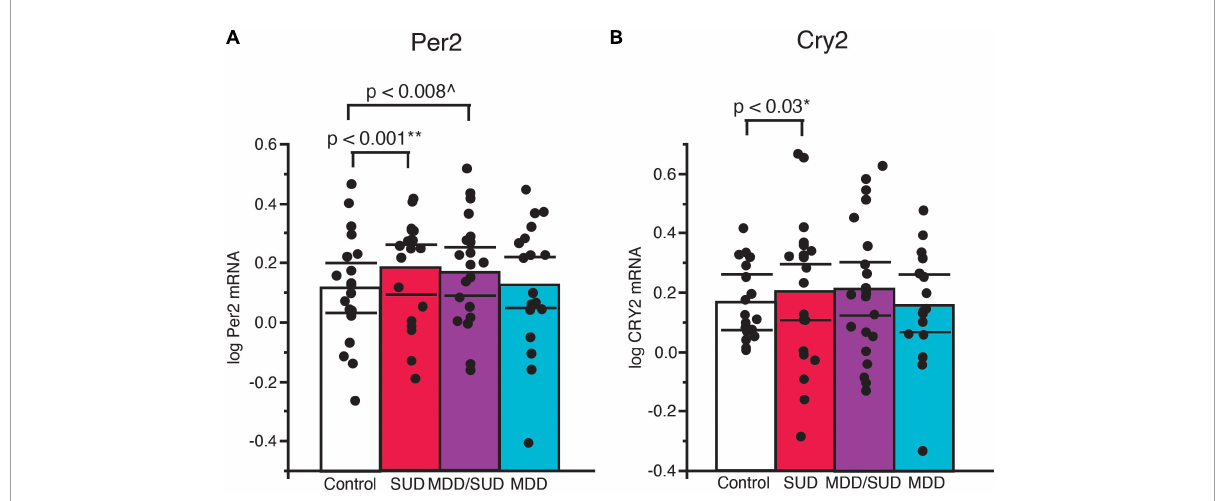
FIGURE5 Altered Per2 and Cry2 expression in the hippocampus of subjects with SUD. (A) ANCOVA analysis detected increased Per2 mRNA expression in subjects with SUD ( p < 0.001; **adjusted for effects of ZT time, calcium channel blockers, and rating of lifetime alcohol exposure). Subjects with comorbid MDD/SUD also displayed significantly increased Per2 expression ( p < 0.008; ˆadjusted for effects of ZT time, history of sleep disturbances, calcium channel blockers, and amount of antipsychotics in the last month of life) (A) . No differences in Per2 expression were detected in subjects with MDD. (B) Increased Cry2 expression was also detected in subjects with SUD ( p < 0.03; *adjusted for effects of ZT time, interaction of ZT time with diagnosis, and duration of alcohol use disorder). No differences in Per2 expression were detected in subjects with MDD/SUD or subjects with MDD. Significance values are derived from stepwise linear regression models. Scatterplots show the mean (histogram) and 95% confidence intervals (black lines).